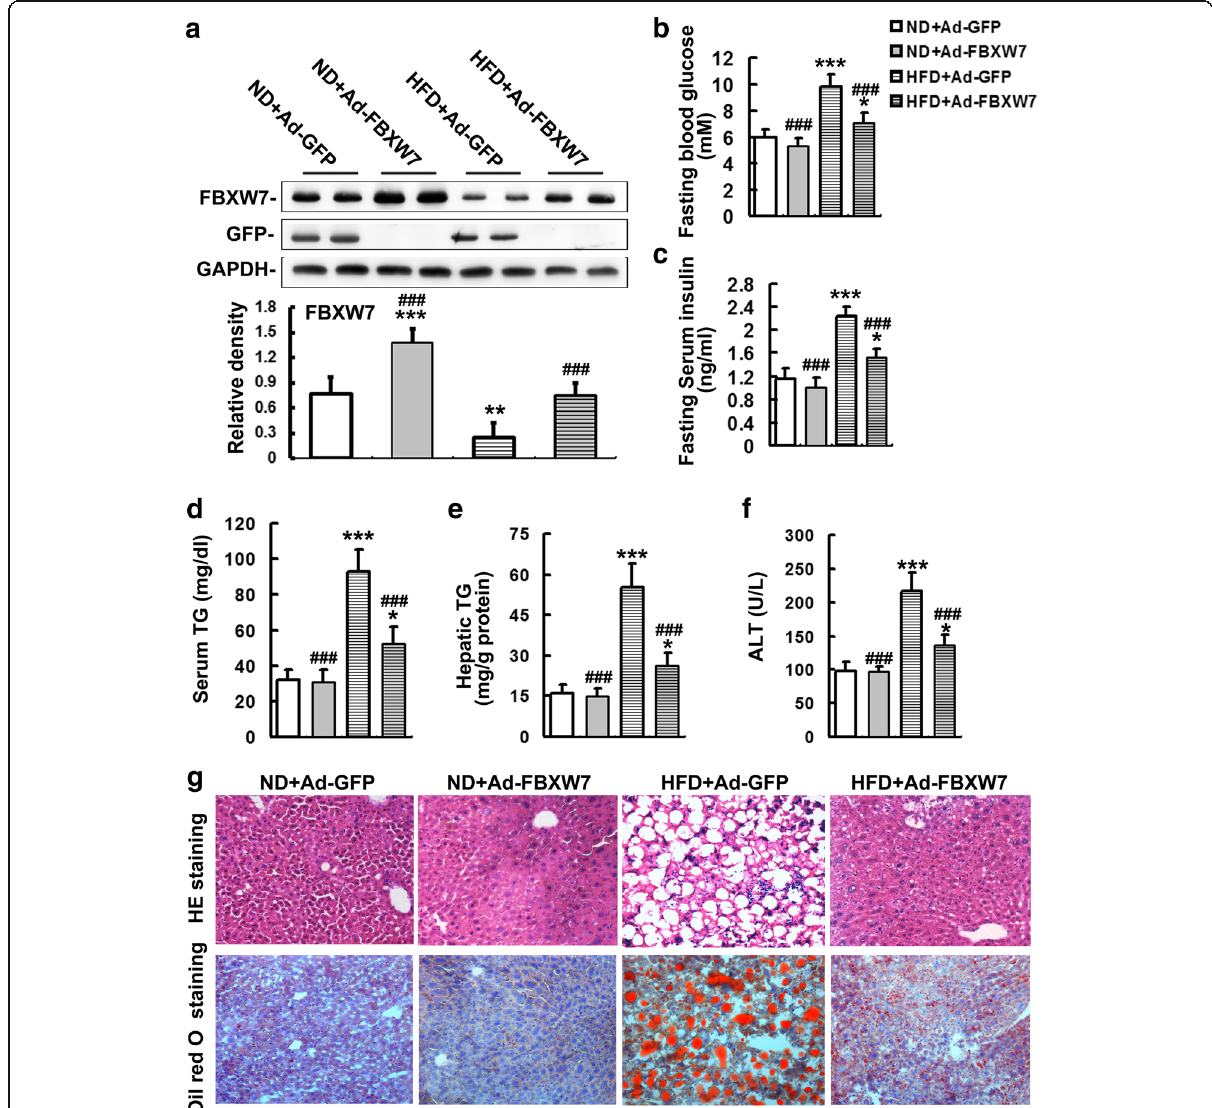
Fig. 1 FBXW7 improves NAFLD and related metabolic parameters in HFD-fed mice ( n = 5). a Immunoblotting and densitometry of FBXW7 and GFP in mouse livers. b The levels of fasting blood glucose in different treatment groups. c The levels of fasting serum insulin in different treatment groups. d Serum TG levels in different treatment groups. e Hepatic TG levels in different treatment groups. f Serum ALT activities in different treatment groups. g H&E staining and Oil Red O staining of liver sections in different treatment groups. Magnification 200X. All of the values are expressed as